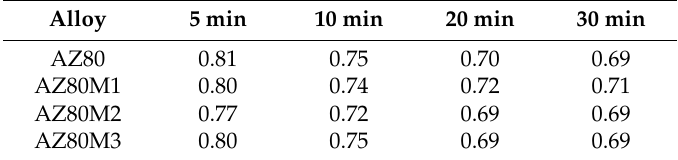
Table 2. Solid fraction of the experimental alloys at 570 ◦ C for various isothermal times.